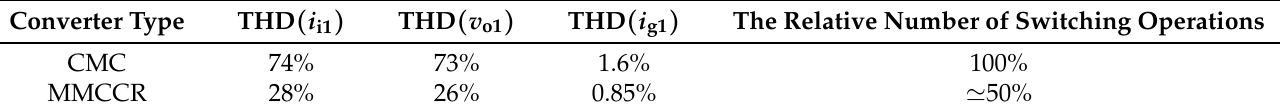
Table 8. Selected results of the comparison CMC and MMCCR converters during SVPWMmodulation. Converter